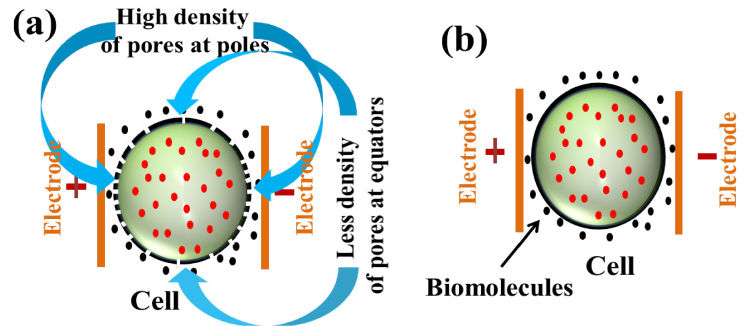
Figure 3. Single cell electroporation (SCEP), where an external electric field applied outside of the single cell ( a ) formation of pores due to electric field application (maximum pores open at poles and minimum pores open at the equators due to different field strength at different positions of the membrane); ( b ) after withdrawing the pulse, cell membranes reseal again and biomolecules enter successfully inside the single